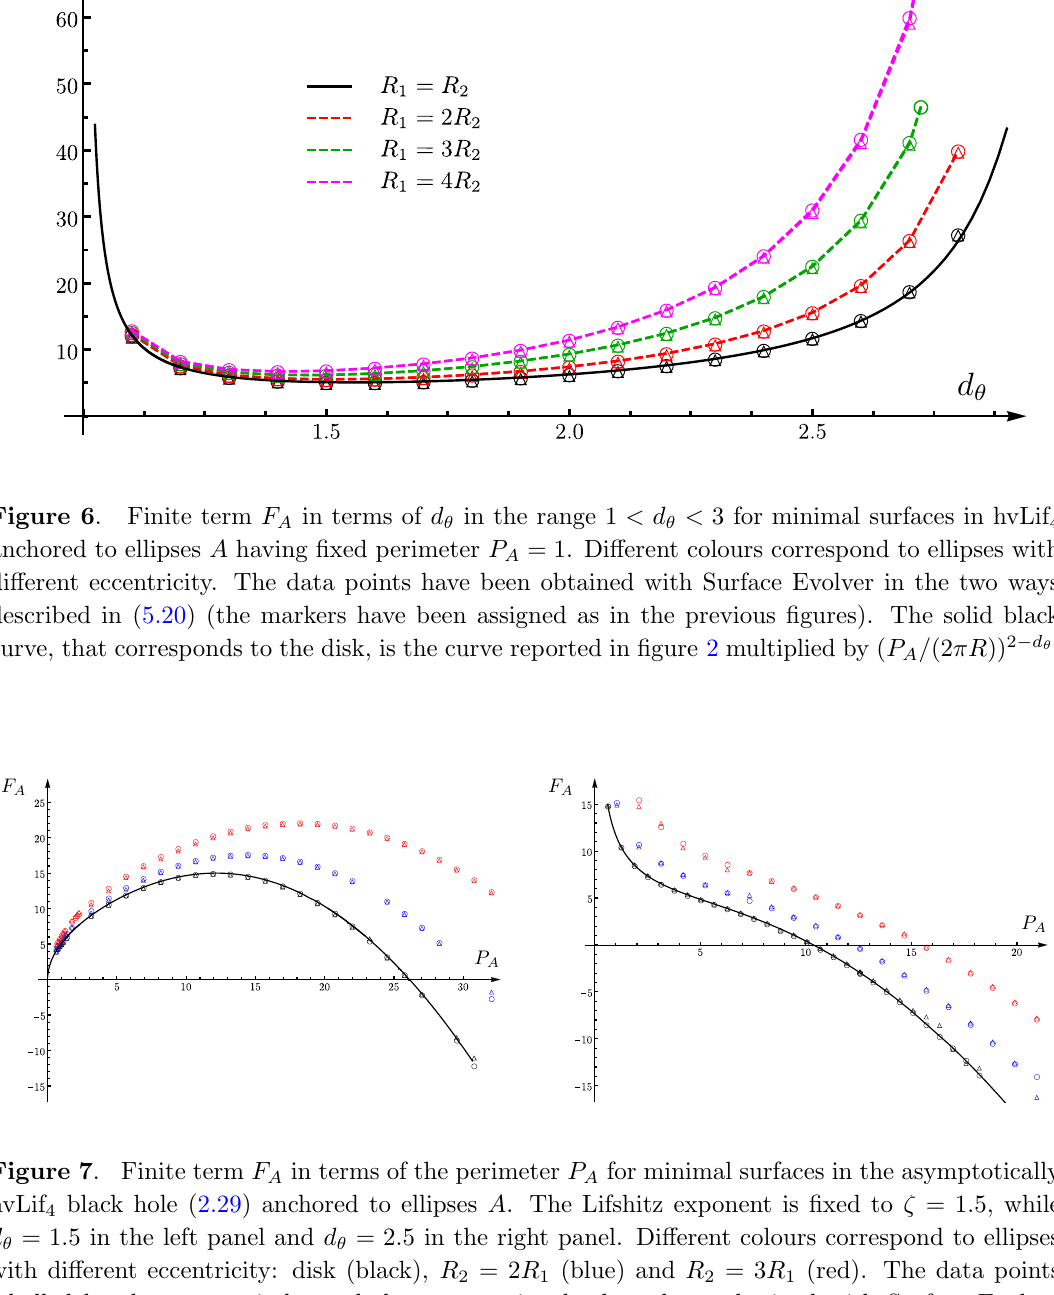
Figure 7 . Finite term F A in terms of the perimeter P A for minimal surfaces in the asymptotically hvLif 4 black hole (2.29) anchored to ellipses A . The Lifshitz exponent is (cid:12)xed to (cid:16) = 1 : 5, while d (cid:18) = 1 : 5 in the left panel and d (cid:18) = 2 : 5 in the right panel. Di(cid:11)erent colours correspond to ellipses with di(cid:11)erent eccentricity: disk (black), R 2 = 2 R 1 (blue) and R 2 = 3 R 1 (red). The data points labelled by the empty circles and the empty triangles have been obtained with Surface Evolver through the two formulas in (5.20) respectively. The solid black curves for disks have been found numerically by employing Mathematica. All the curves and the data points have been obtained by using (2.18).